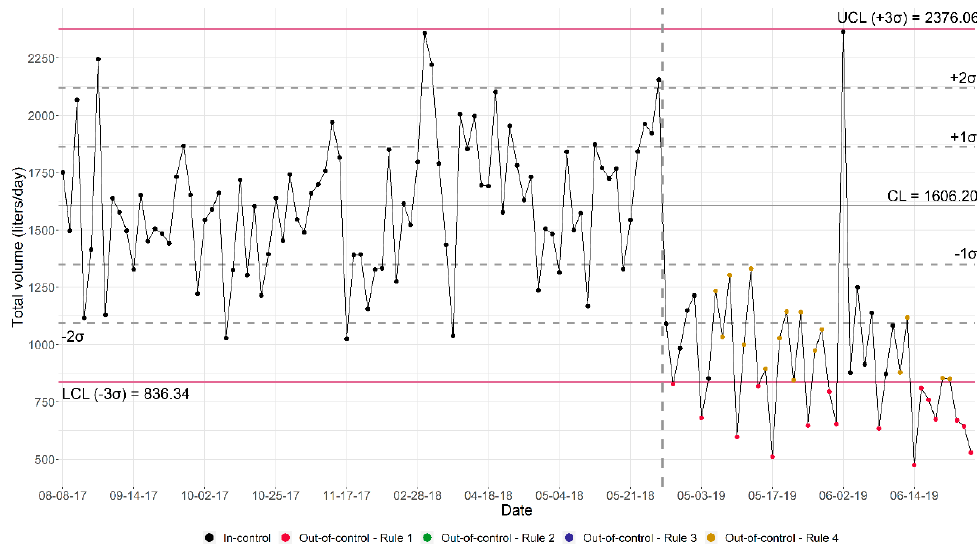
Figure 1. Shewhart Control Chart—Total volume per day.